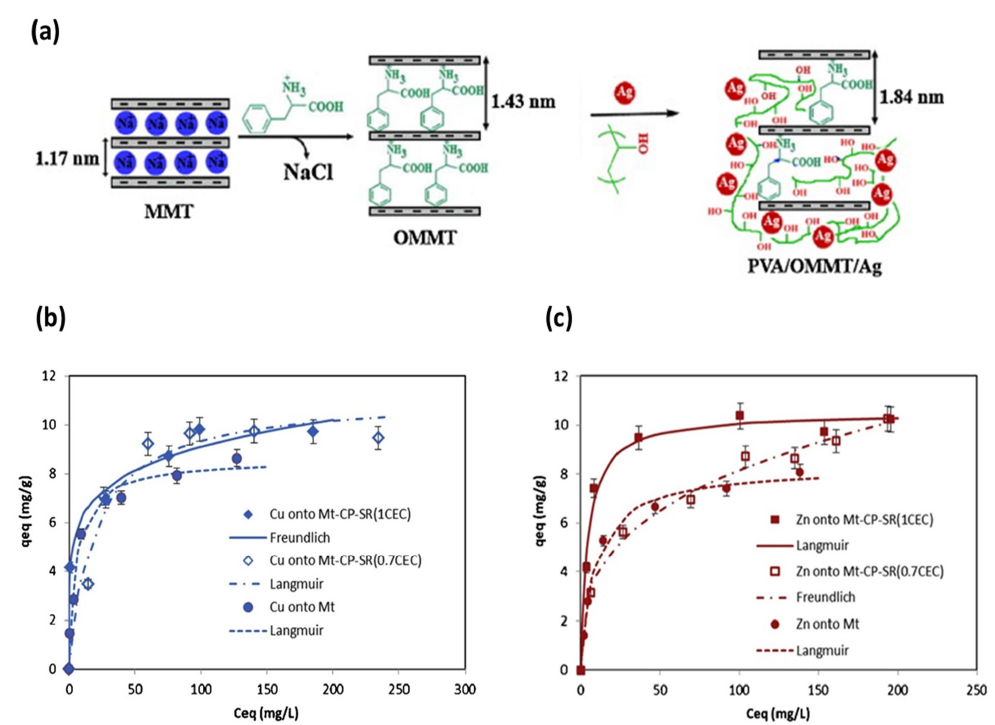
Figure 4. ( a ) Schematic illustrations for preparation of PVA/OMMT/Ag NC films. Adapted from [191], with permission from Elsevier (Copyright 2014). Adsorption of ( b ) Cu 2+ and ( c ) Zn 2+ onto the MMT-Na, MMT-CP-SR (0.7CEC), and MMT-CP-SR (1CEC). Adapted from [214], with permission from Elsevier (Copyright 2020, Elsevier).